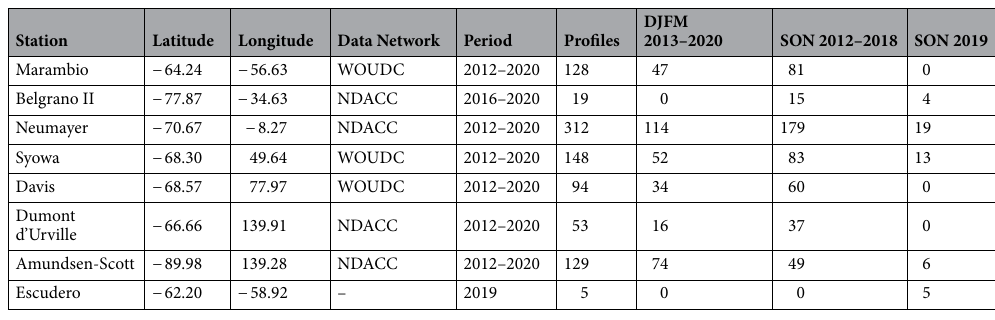
Table 1. Number of ozone profiles considered in the comparisons, over the periods: DJFM 2013–2020, SON 2012–2018, and SON 2019.